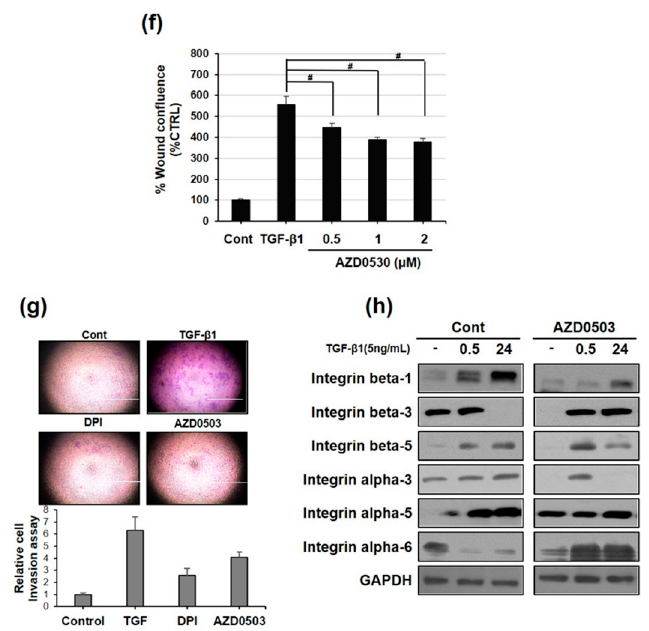
Figure 6. TGF- β 1 induces Src activation, and AZD0530 inhibits TGF- β 1-induced Src activation in a time-dependent manner in HeLa cells. ( a ) Expression of focal adhesion kinase (FAK), Src, and their phosphorylation after TGF- β 1 (5 ng/mL) treatment for different times in HeLa cells, as measured by Western blot analysis. ( b ) Effect of NOX and a reactive oxygen species (ROS) inhibitor on TGF- β 1-stimulated phosphorylation of SRC and FAK. After pre-incubation for 1 h with inhibitors, cells were grown in the presence of TGF- β 1 for 6 h and then analyzed. ( c ) Cells were transfected with NOX2 or NOX4 siRNA for 0, 30 min, and 24 h. After 24 h, total extracts were obtained. The content of SRC (Y416) and FAK (Y379) was assessed by Western blotting. ( d ) Activation of MAPK and Akt in response to TGF- β 1 signaling. HeLa cells were exposed to TGF- β 1. After 0, 0.5, and 24 h, HeLa cells were pre-incubated with AZD0530 (a SRC inhibitor) for 1 h. After TGF- β 1 was added for 0, 0.5, and 24 h, phospho-ERK/ERK, phospho-p38MAPK/p38MAPK, phospho-JNK/JNK, the total form of each MAPK, and Src levels were analyzed by Western blotting. ( e ) The Src inhibitor AZD0530 (50 nM) was added 1 h before stimulation with TGF- β 1. NOX2 and NOX4 protein expression in TGF- β 1-treated cells at 0.5, 1, 2, 4, and 6 h is shown. ( f , g ) Migratory capacity of cells before treatment with AZD0530 for 24 h was analyzed by migration (f) and transwell assays (g). The invasive capacity of the cells was analyzed using Transwell filter chambers coated with Matrigel. ( h ) AZD0530 inhibits TGF- β 1-induced integrin expression. Results show that TGF- β 1 regulates integrin protein expression and indicate the inhibition of integrin by a SRC inhibitor. GAPDH expression was included as a loading control. # represents that the experimental outcome is statistically significant.